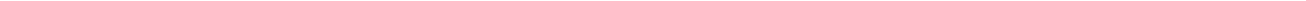
Figure 4 | SFKs are critical for human pDC cytokine production. ( a , b ) CAL-1 cells ( a ) or human PBMCs ( b ) were pre-treated for 1h with PP2 or DMSO control and then stimulated with R848 for 15h. Viability was assessed by flow cytometry, while type I IFN and TNF protein levels in the supernatant were assessed by bioassay and ELISA, respectively. ( c – e ) Human PBMCs were pre-treated for 1h with PP2 (5 and 15 m M) or DMSO control and then stimulated with R848 for 6h and subsequently intracellular stained for TNF and IFN- a . FACS plots show the co-expression of TNF and IFN- a in gated pDCs ( c ). The percentage of pDCs single positive to IFN- a and TNF staining ( d ). MFI of IFN- a and TNF in gated pDCs ( e ). ( f ) LYN and GAPDH protein expression in unmodified CAL-1 cells (LYN þ ) and CAL-1 cells ablated for LYN by CRISPR/Cas9 (LYN (cid:2) ) was determined by immunoblot. ( g , h ) The expression of IFN- b and TNF mRNAs was determined by qPCR ( g ) and the level of protein in the supernatant was quantified by bioassay or ELISA ( h ) in LYN þ and LYN (cid:2) CAL-1 cells after 1 or 15h stimulation with R848, respectively. In g , the mRNA expression were normalized against GAPDH expression and plotted as mRNA fold increase compared to unstimulated cells. Data are representative of two ( g ) or three ( a , f , h ) independent experiments or four donors processed separately ( b – e ). Graphs depict mean ± s.d. of replicates within one representative experiment/donor. Dunnett’s multiple comparisons test ( a , b , d , e ) and two-ways Student’s t -test ( f , g ) were used for statistical analyses. * P o 0.05, ** P o 0.01, *** P o